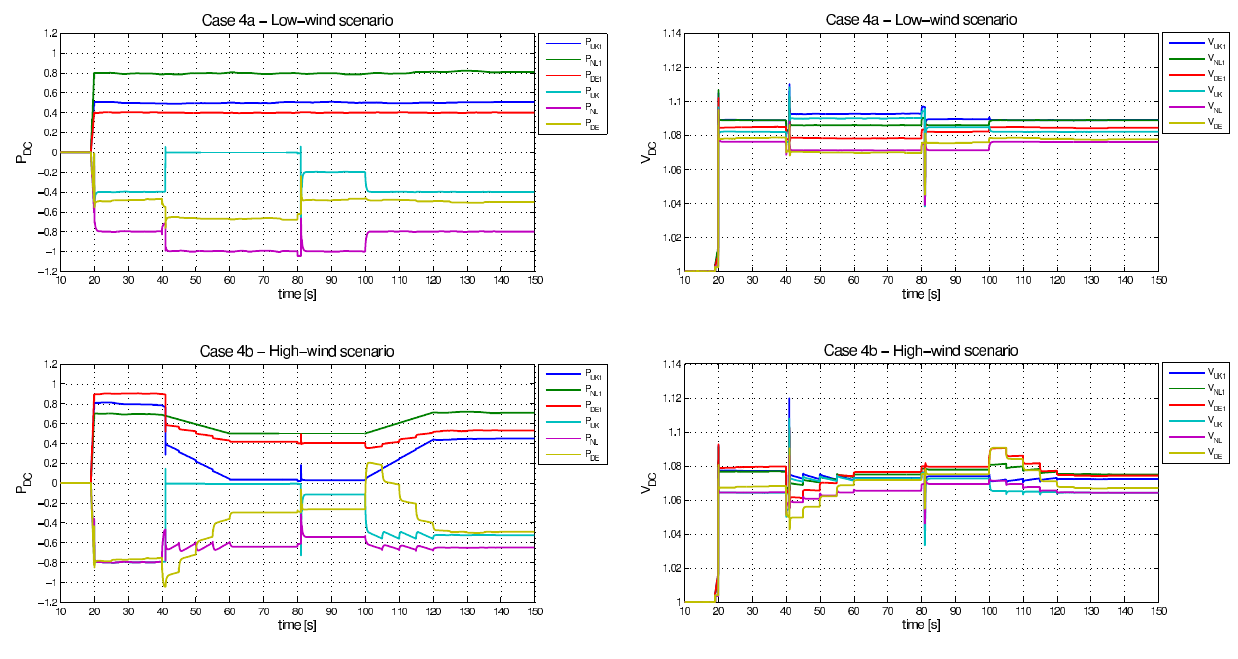
Figure 14. Results from Case Study 4: AC fault in the UK